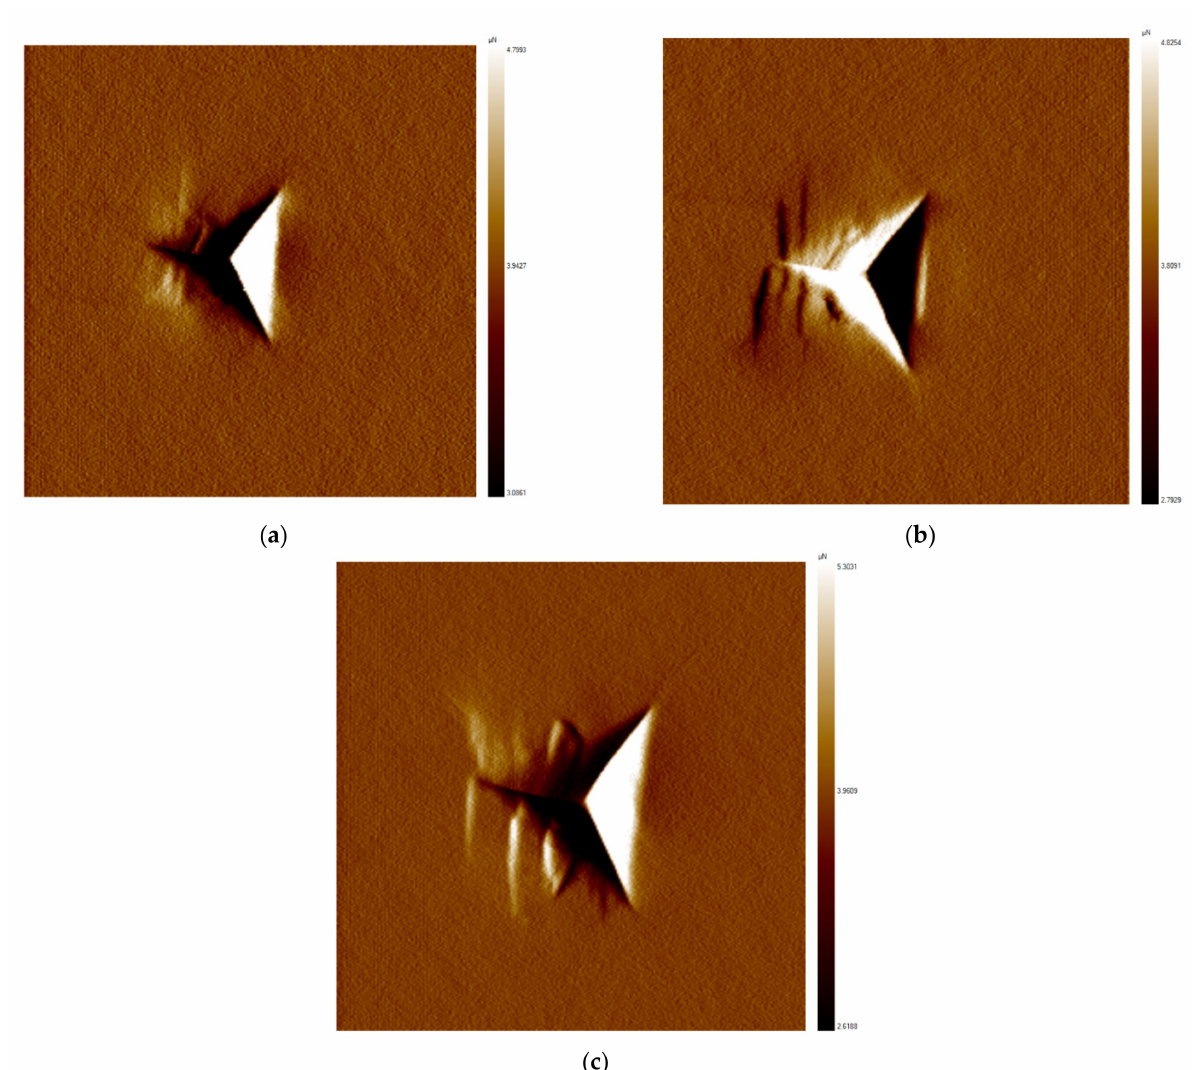
Figure 11. LN surface fracture under high loads. ( a ) 11 mN; ( b ) 13 mN; ( c ) 15 mN.